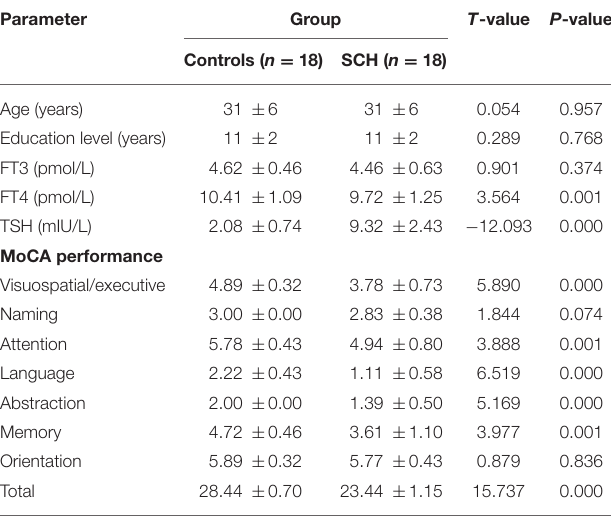
TABLE 1 | Clinical information and neuropsychological data of the subjects (mean ± SD). Parameter